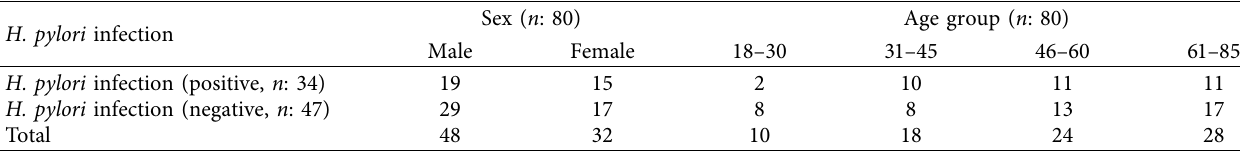
Table 3: Demographic data of the prevalence of H. pylori infection among males and females with various age groups. H. pylori infection